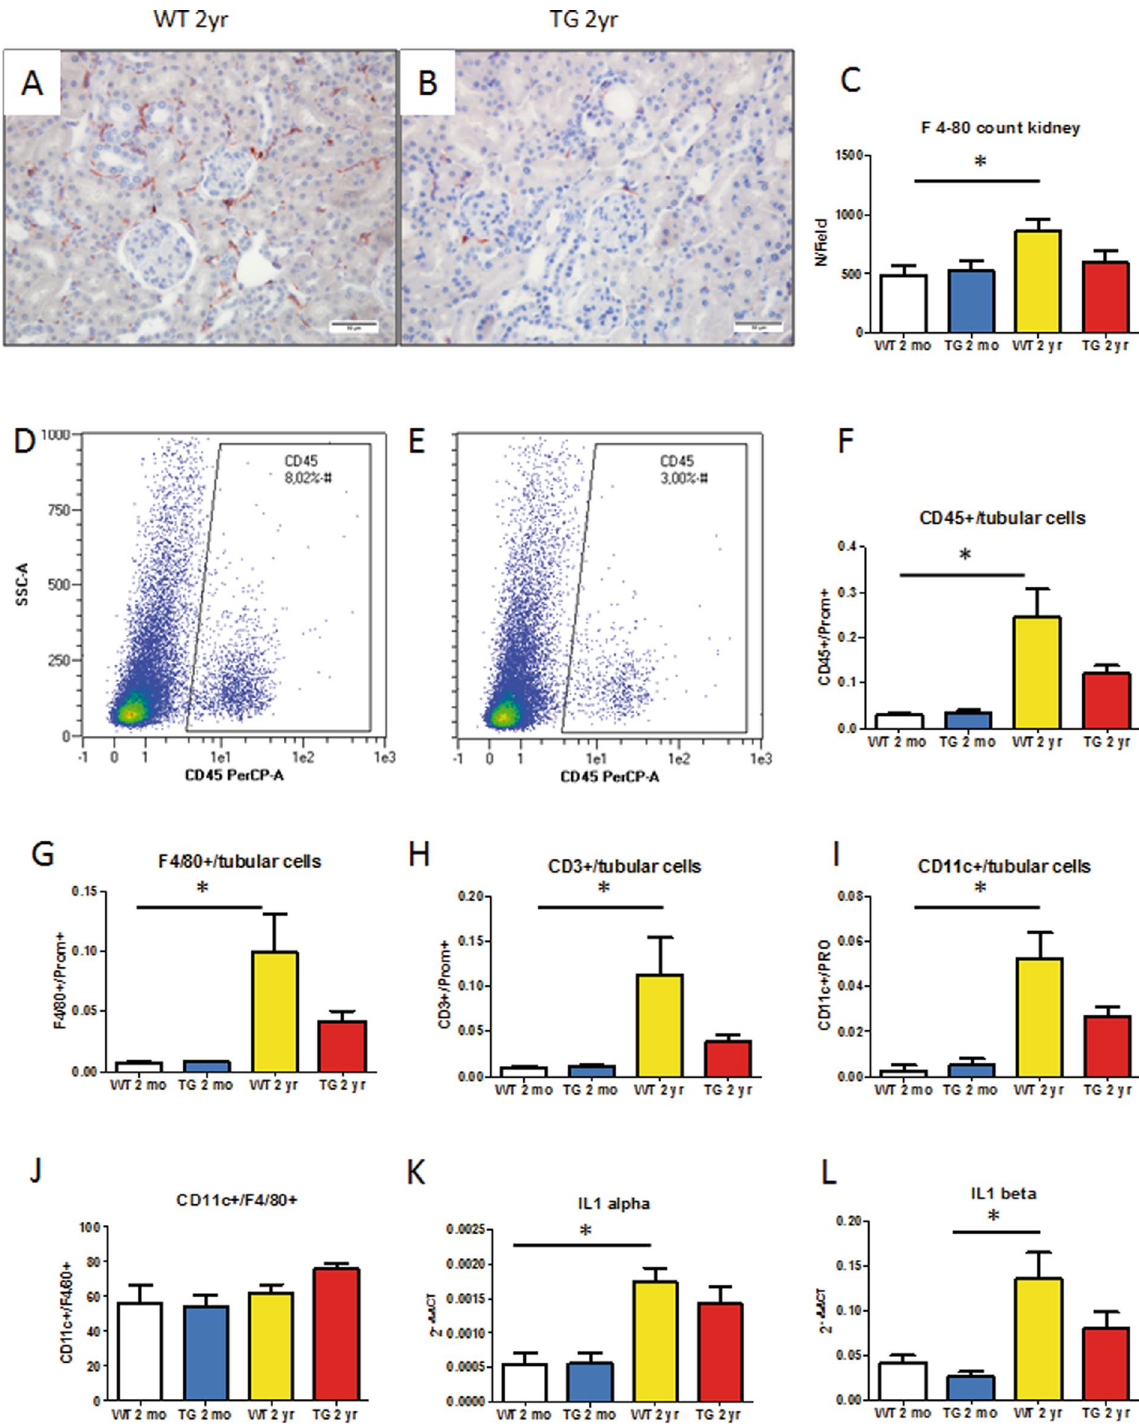
Figure 10. Calpastatin overexpression protects against kidney inflammaging. Kidney infiltration by F4/80 + macrophages was assessed first by immunohistochemistry, evidencing a significant increase with aging in WT mice only ( A–C , * p < 0.05, n = 8/group, magnification × 400). To improve immune cell quantification, tissue flow cytometry has been performed in another set of experiments to assess the CD45 + (immune cells)/prominin1 + (proximal tubular cells) ratio, evidencing that immune cell infiltrate increased significantly in WT mice only ( D–F , * p < 0.05, n = 4–6/group). The proportion of macrophages, including M1 CD11 + macrophages, and lymphocytes was significantly increased in old WT mice kidneys only ( G,H,I * p < 0.05, n = 4–6/group). Nevertheless, the proportion of M1 macrophages was similar in both WT and CalpTG kidneys ( J , n = 4–6/group). Il-1 α expression was very faint in kidney tissue but significantly higher at 2 years in WT mice kidneys when compared to young mice kidneys ( K , * p < 0.05, n = 6/group). Il-1 β was quantitatively more expressed but its expression differed significantly only between aged WT and young CalpTG (TG) (L, * p < 0.05, n =